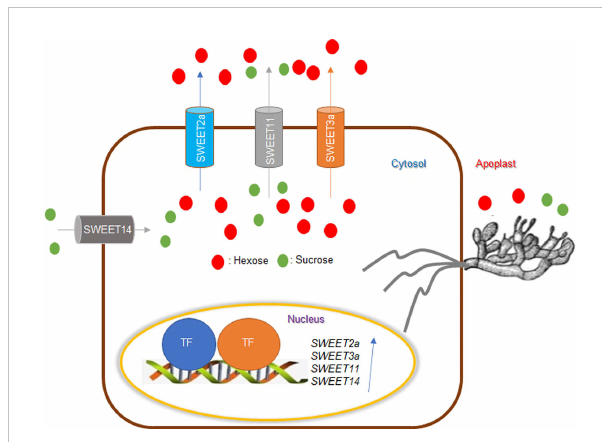
FIGURE 2 Effects of sugar on rice ShB. SWEET transports hexose and sucrose across the membrane. SWEET11 / Os8N3 plays a vital role in seed fi lling and can also be exploited by pathogens to transport sugar to the extracellular space to provide nutrients for pathogens. While the sweet11 mutant showed resistance to multiple pathogens, it is defective in seed fi lling, thus reducing yield. Rhizoctonia solani AG1- IA effector AOS2 is secreted and targeted in the nucleus to interact with WRKY53 and GT1 to activate SWEET2a and SWEET3a to ef fl ux sugar for nutrition. SWEET2a and SWEET11 negatively regulate ShB resistance in rice. Alternatively, SWEET14 contributes to ShB resistance in rice. Sugar transporters are extensively involved in the interaction between rice and